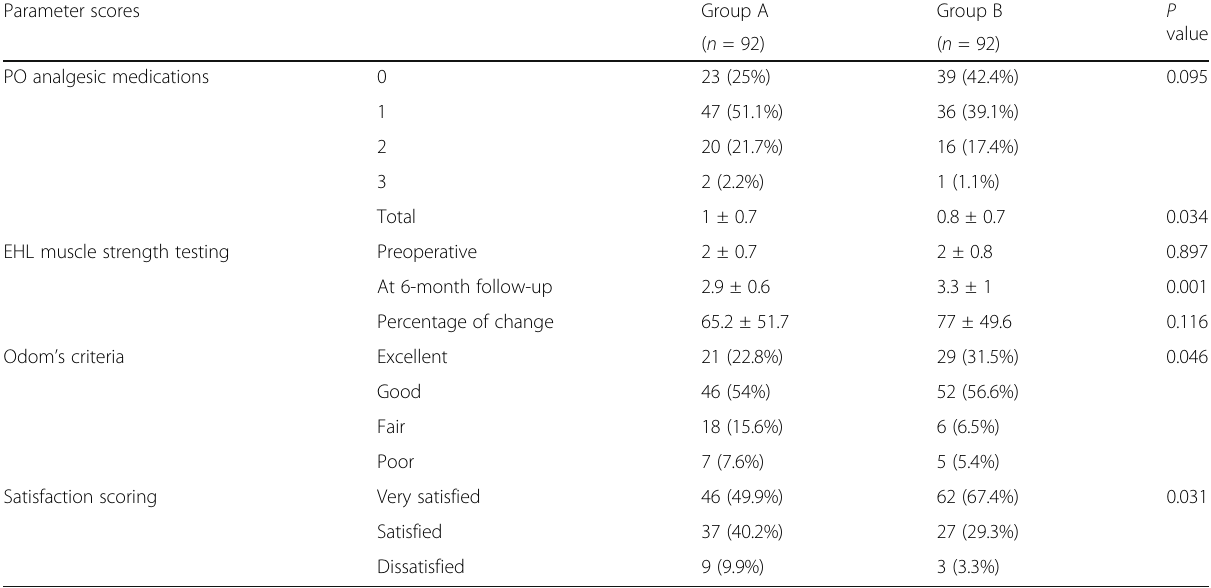
Table 6 Postoperative data of studied patients Parameter